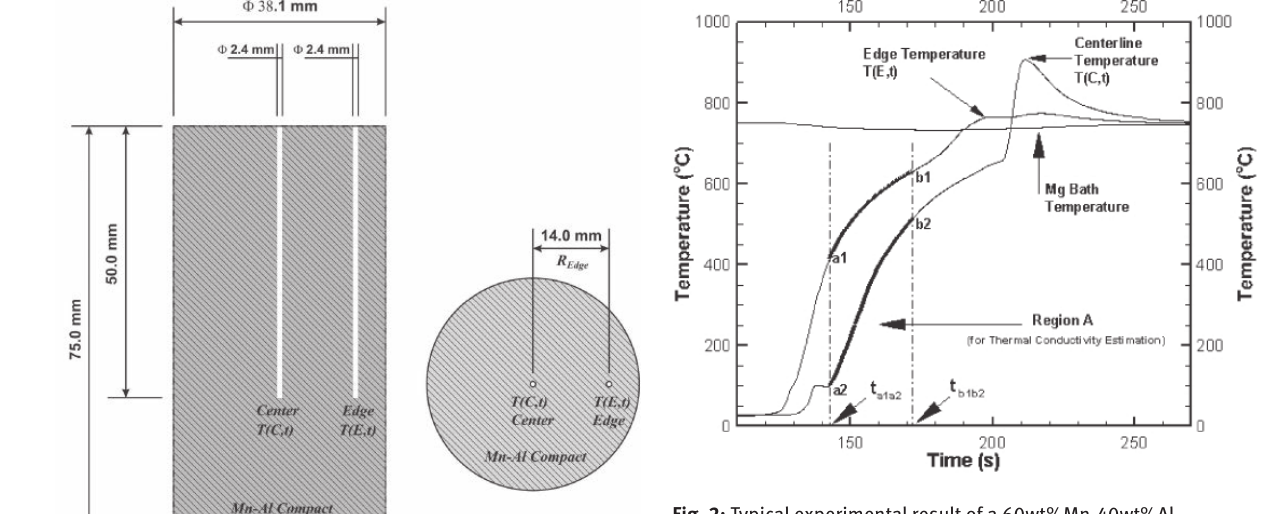
Fig. 2: Typical experimental result of a 60wt%Mn-40wt%Al cylindrical compact where the IHTP